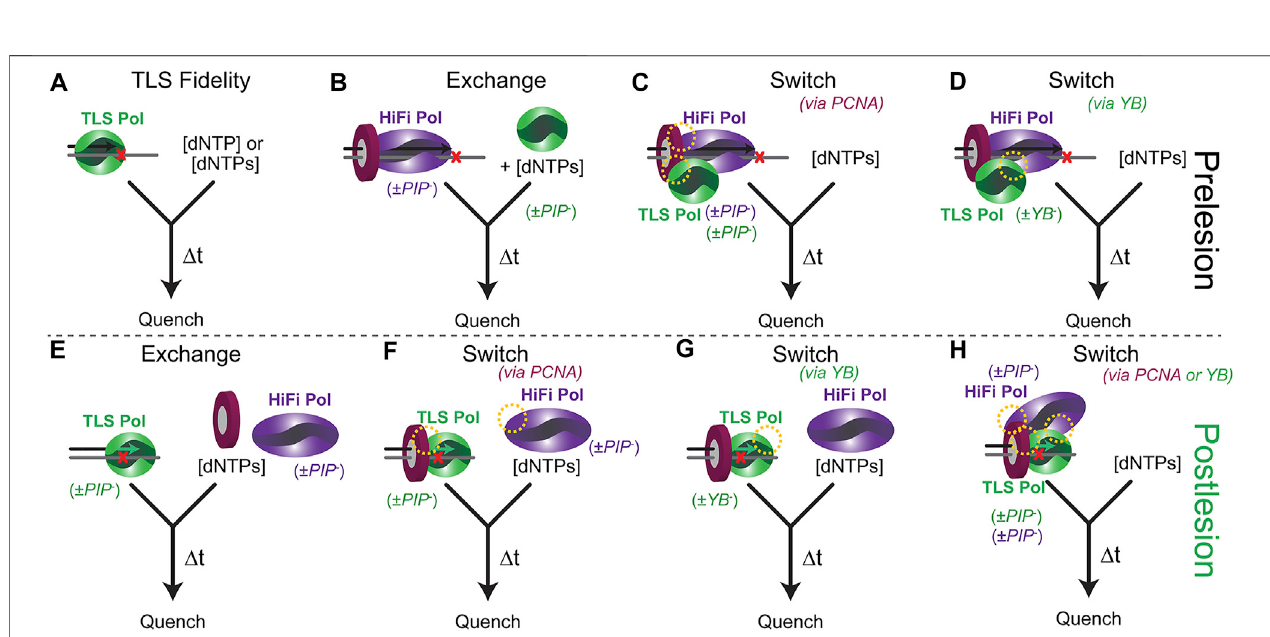
FIGURE 4 | Experimental presteady-state schemes to examine the TLS process both pre and post lesion. (A) TLS Pol and various DNA template lesions to examineinherent fi delityinisolation. (B) PreboundHiFiPolwithPCNAstalledtoexamineakinetic exchange process.PreassembledsupraholoenzymecomplexwithHiFi and TLS Pols bound to DNA to examine kinetics of switching directed (C) by interactions with PCNA (PIP sites) or (D) through Pol-Pol interactions (YB site) (yellow circles). (E) ATLS Pol with aprimer that isa de fi ned number ofbases past alesion isused to examine a distributive exchange , (F) a PCNA directed switch , or (G) a YB directed switch . (H) The kinetics of a preassembled PCNA/TLS/HiFi Pol directed switch back to high fi delity synthesis can be validated by utilizing PIP − or YB − mutants of all Pols.